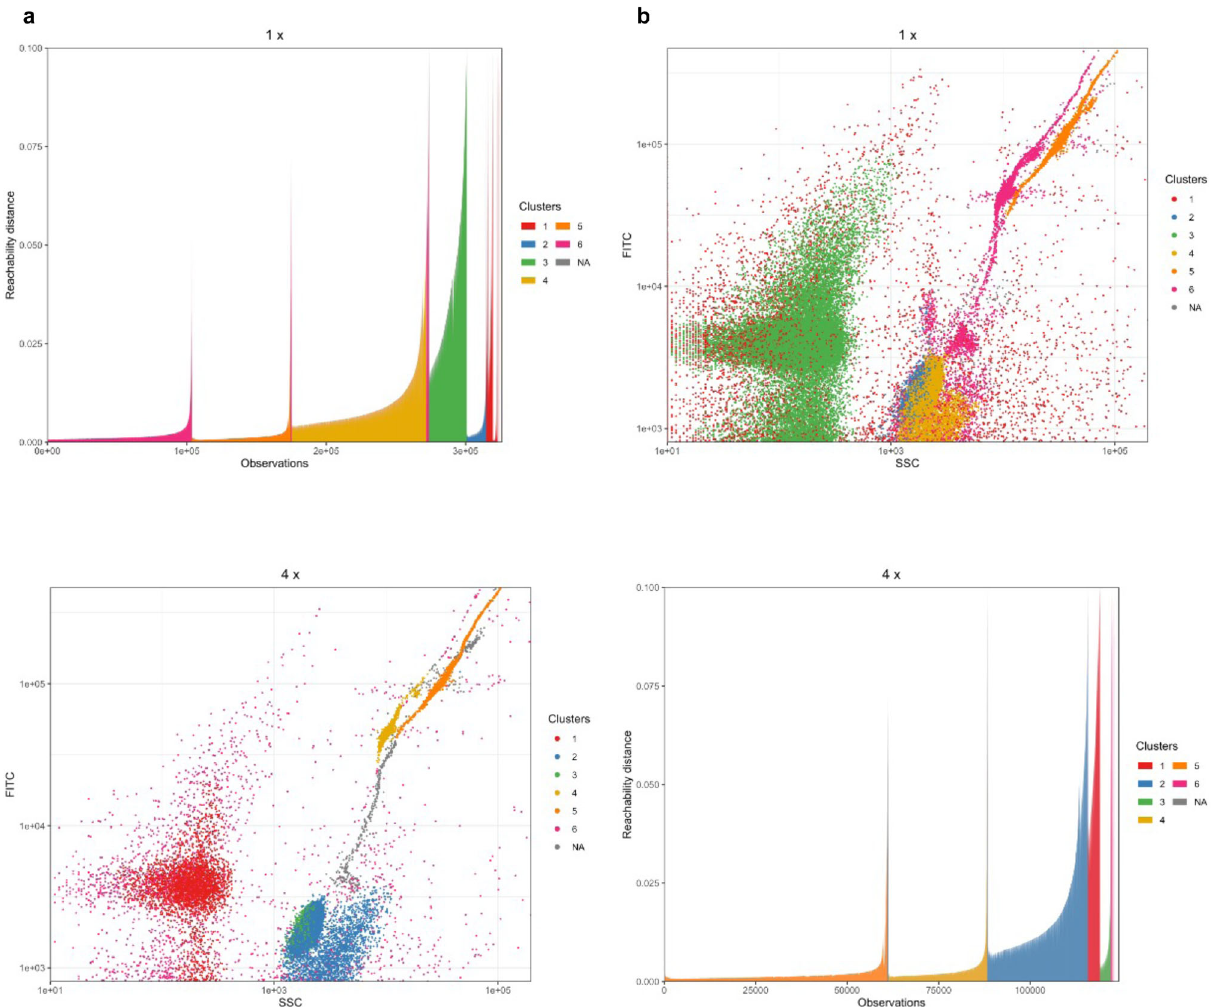
Fig. 5 Representative results of using the opticskxi algorithm to extract clusters from the same OPTICS-ordered data shown in Fig. 4. Representative results for additional dilutions are available in Supplementary Fig. 5. Panel a plots show the OPTICS ordering of the data from which the clusters were algorithmically extracted. Colors highlight each algorithmically extracted cluster. Panel b plots visualize the data as SSC vs. FITC plots, with points colored based on the cluster extraction. Cluster colors are consistent between the two plots for each dilution, but not necessarily between different